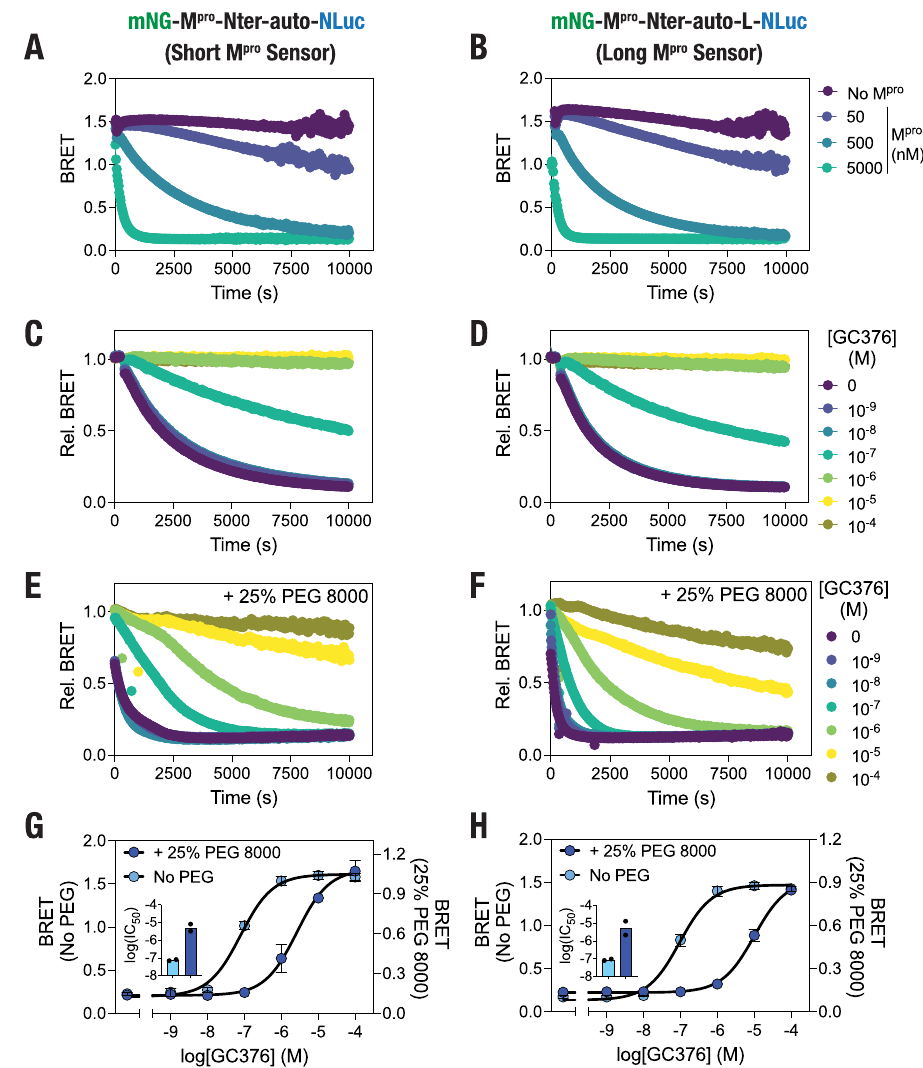
Fig. 6 Molecular crowding-mediated increase in M pro proteolytic activity and decrease in GC376 potency. A , B Graph showing in vitro proteolytic cleavage kinetics of the short ( A ) and the long ( B ) M pro biosensor under the indicated concentrations of the recombinantly puri fi ed M pro protein. C , D Graphs showing GC376-mediated inhibition of SARS-CoV M pro proteolytic cleavage of the short ( C ) or the long ( D ) M pro sensors. E , F Graphs showing GC376-mediated inhibition of M pro proteolytic cleavage of the short ( E ) or the long ( F ) M pro sensors in the presence of 25% (w/v) of PEG 8000. G , H Graph showing concentration-dependent inhibition of M pro determined using either the short ( G ) or the long ( H ) M pro sensor in the absence or in the presence of 25% (w/v) of PEG 8000. Inset in G , H : graphs showing log(IC 50 ) values of GC376 in the absence and presence of 25% (w/v) of PEG 8000. Data shown are mean obtained from assays repeated twice, with each experiment performed in